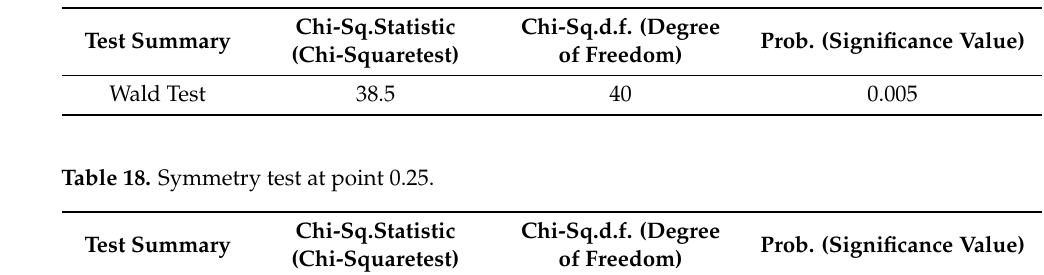
Table 17. Slope equality test at point 0.25.